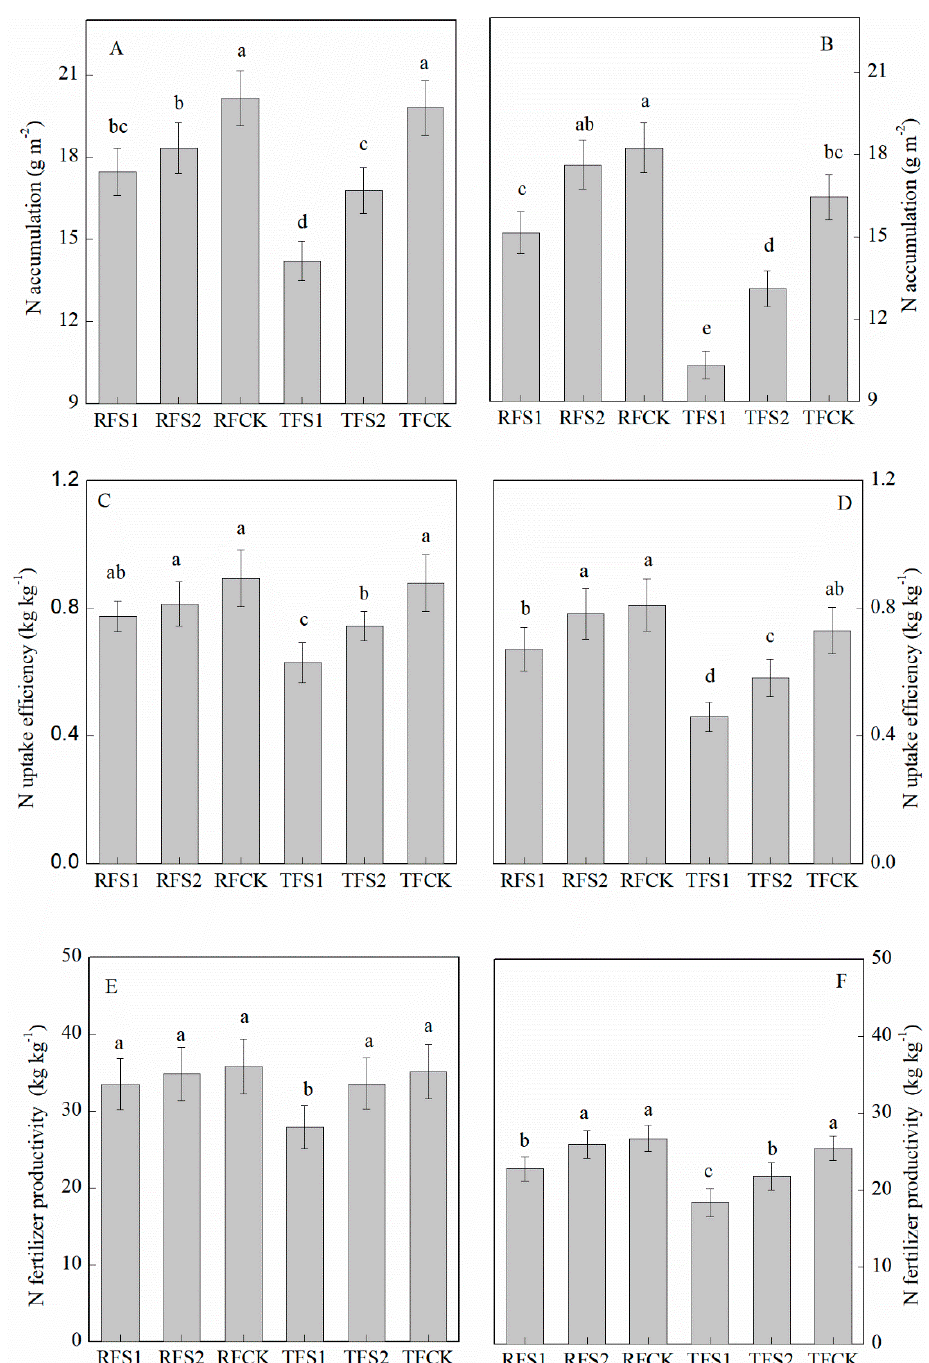
Figure 8. Effects of planting and irrigation on the nitrogen use efficiencies of wheat (A, C and E: 2016- 2017; B, D and F: 2017-2018). RF: plastic-covered ridge and furrow planting; TF: traditional